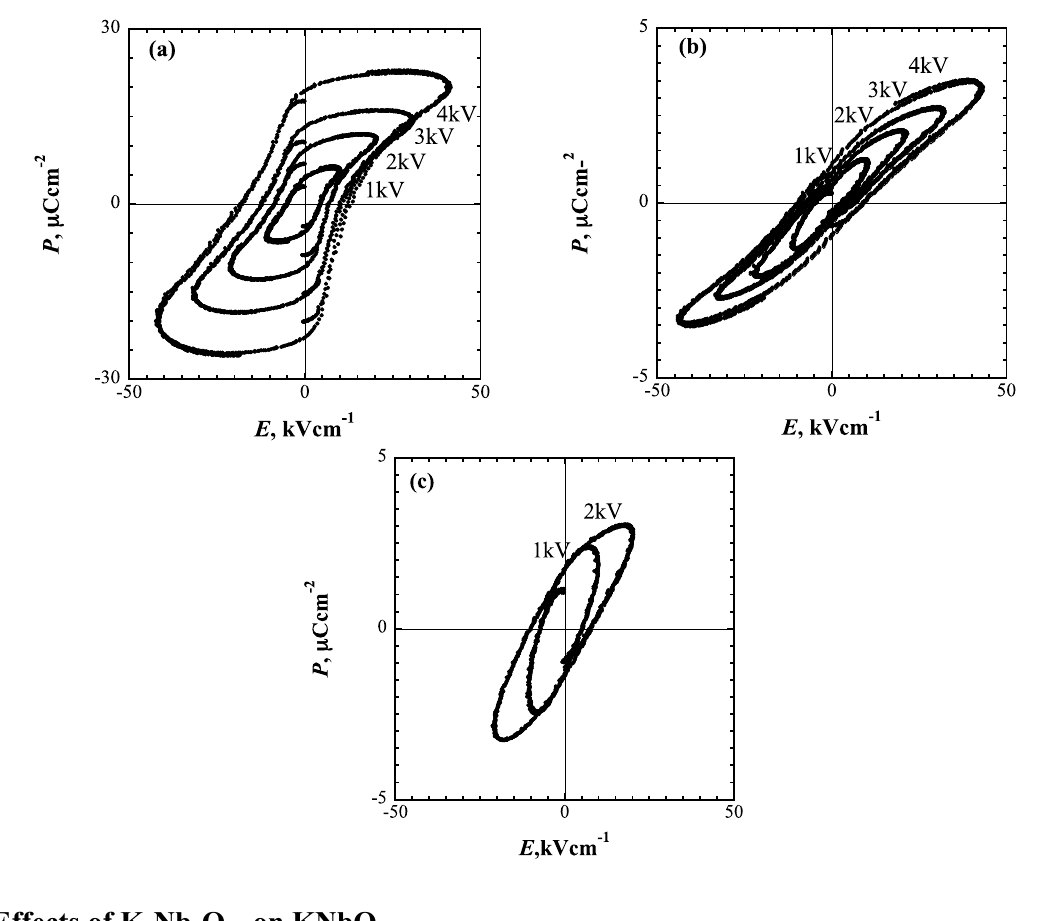
Figure 13. P-E hysteresis loop on bulk crystals ( a ) KN: KNbO ( c ) KNCN: (K,Na,Cs)NbO WILEY-VCH Verlag GmbH & Co.